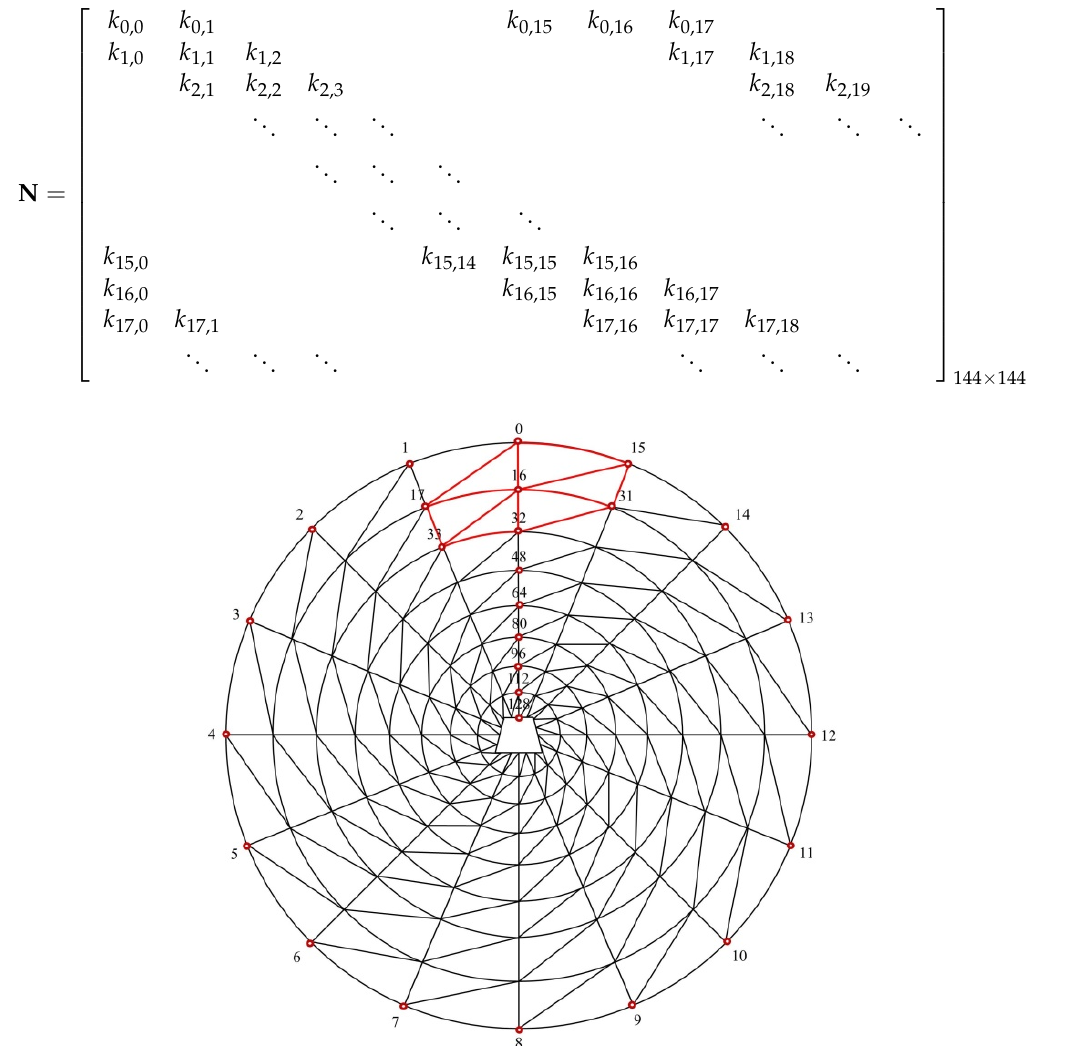
Figure 3. Mesh generation of the model of surrounding rock heat dissipation for trapezoid roadways in a coal mine.